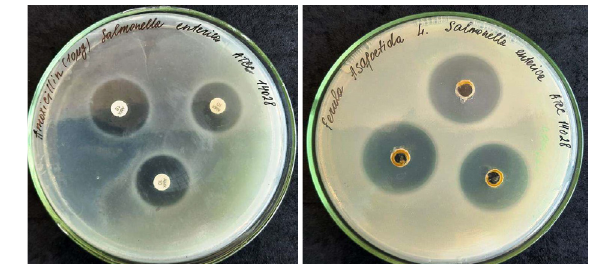
Fig. 7. Results of antimicrobial activity of CO Ferula asafoetida L. and amoxicillin against Klebsiella pneumoniae ATCC 700603